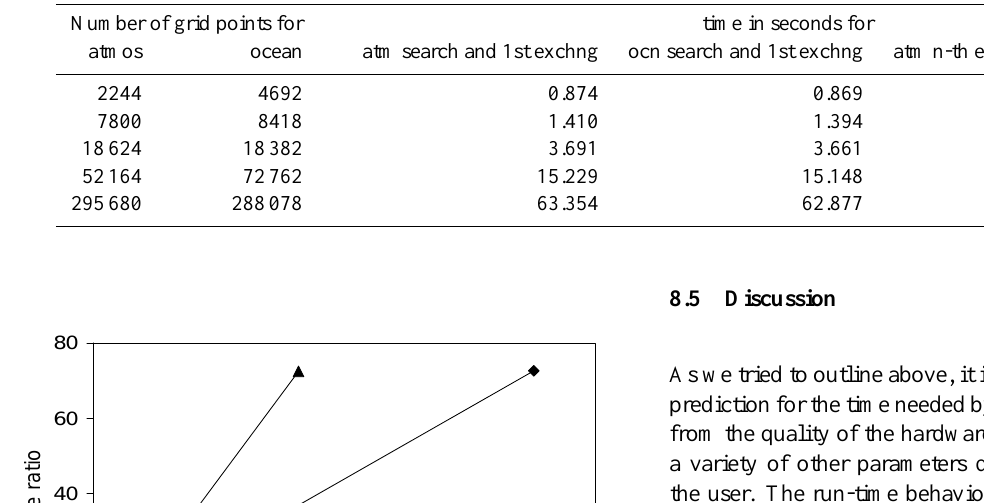
Table 4. Performance of OASIS4 for 2-D search and exchange.